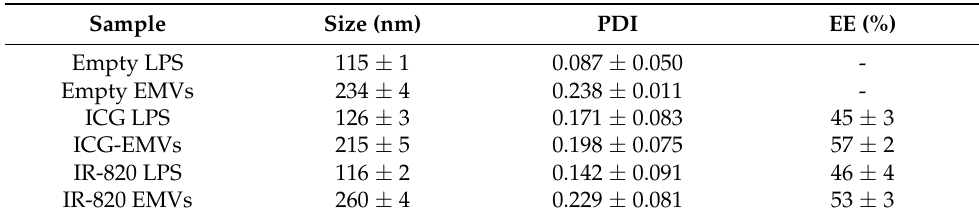
Table 3. Particle size, polydispersity index (PDI), and dye encapsulation efficacy (EE) of empty, ICG-, and IR-820-loaded liposomes and EMVs ( n = 3).